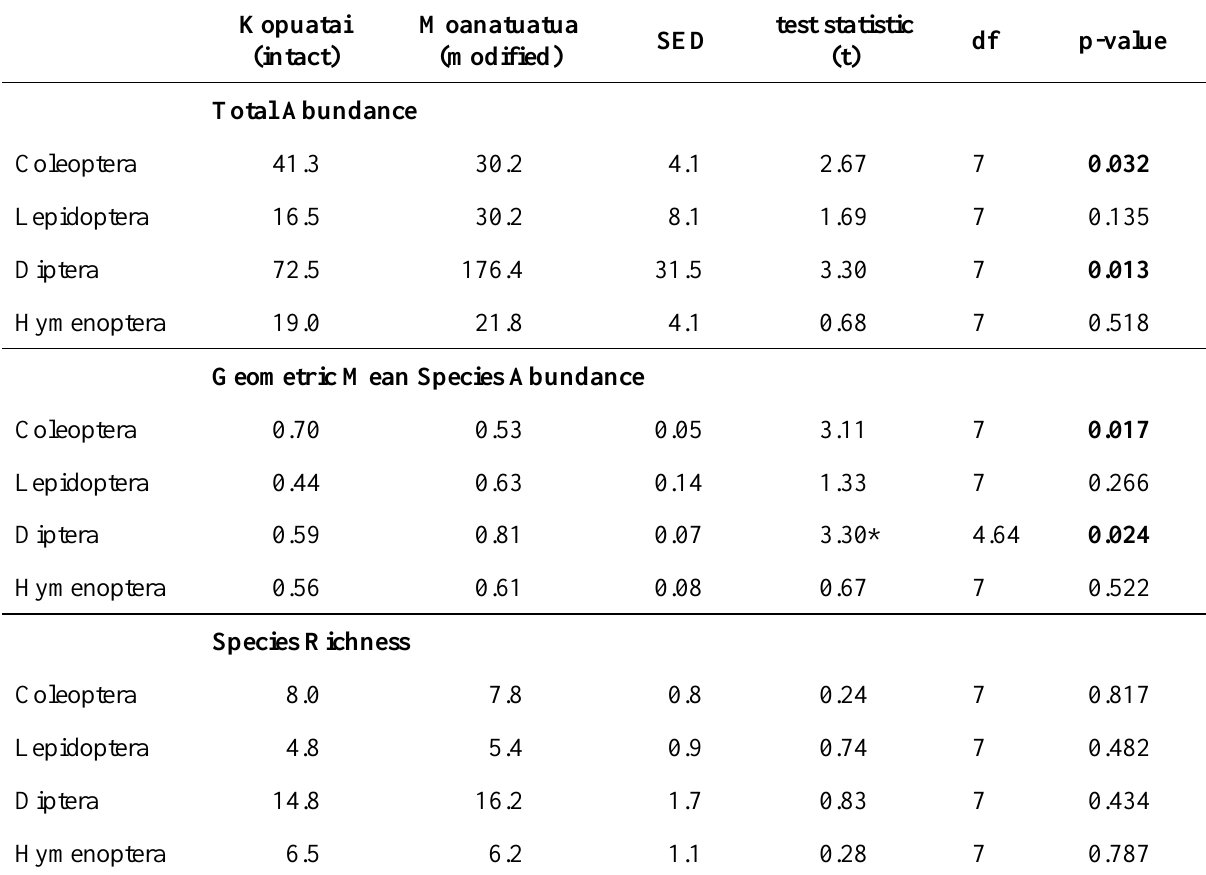
Table 1. Observed means per plot of total abundance, geometric mean species abundance and species richness sampled using Malaise traps at intact and modified raised peat bogs in New Zealand for the four most common Orders. Also given is the results of two-sample 2-sided t-tests for differences between these sites (SED = standard error of the difference; df = degrees of freedom). * denotes that the t-test used separate variance estimates for each peat bog rather than a pooled variance estimate. p- values ≤ 0.05 are in bold. Invertebrates were sampled using a mini Malaise trap placed in the centre of each study plot (4 plots at Kopuatai and 5 plots at